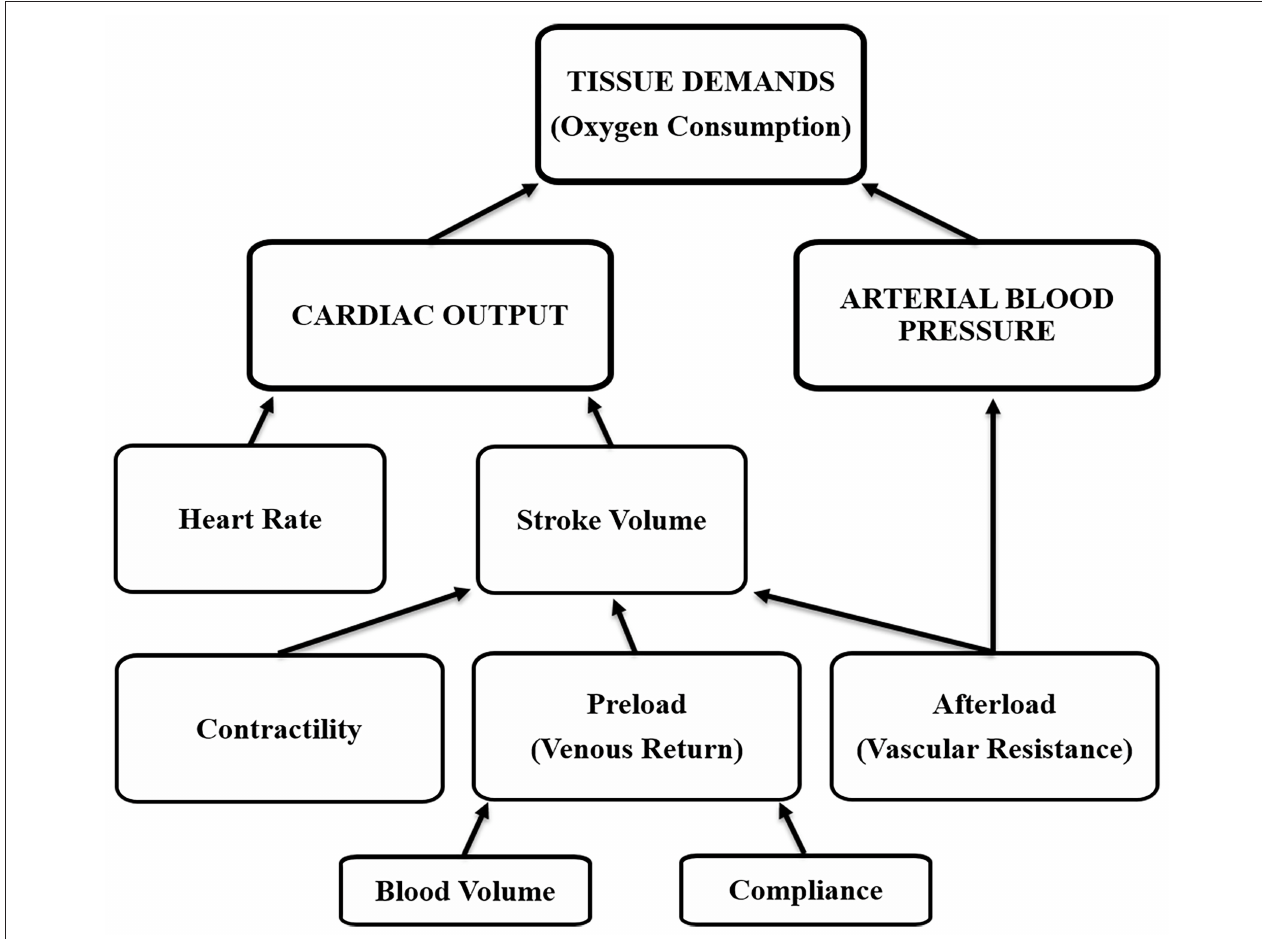
FIGURE 1 | Tissue oxygen demands are met by cardiovascular factors that affect cardiac output and arterial blood